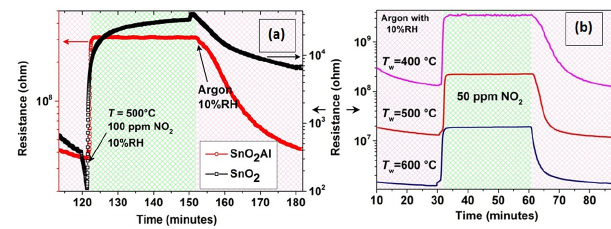
Figure 4. (a) Comparison of dynamic responses of SnO 2 ( (cid:3) ) and SnO 2 :Al ( (cid:13) ) layers towards 100ppm NO 2 gas in 10% RH at 500 ◦ C. (b) Typical dynamic response of the SnO 2 :Al sensor towards 50ppm NO 2 with a cycle of 30min switching the gas ON/OFF at T w = 400, 500 and 600 ◦ C in 10% RH. Figure 5. (a) The dynamic responses of SnO 2 :Al sensors when